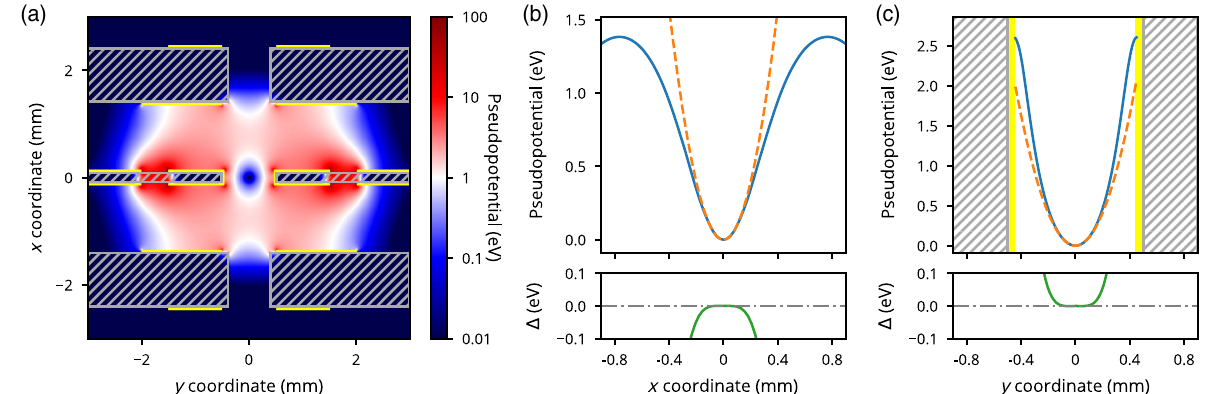
FIG. 2. Electron trapping potential. (a) Contour plot of the trapping potential based on the pseudopotential approximation in the xy plane in the center of the slot for 90-Vamplitude at 1.6-GHz frequency on the resonator electrode. The circuit board substrate is indicated by the hashed areas; metal electrodes are highlighted in yellow. (b) Top: pseudopotential along the x axis through the trap center (blue continuous curve), compared to an ideal harmonic potential (dashed orange). Bottom: deviation Δ of the pseudopotential from the harmonic potential. (c) Top: pseudopotential along the y axis through the trap center (blue continuous curve), compared to an ideal harmonic potential (dashed orange). Location of the trap substrate (electrodes) shown as the hashed grey (solid yellow) area. Bottom: deviation Δ of the pseudopotential from the harmonic